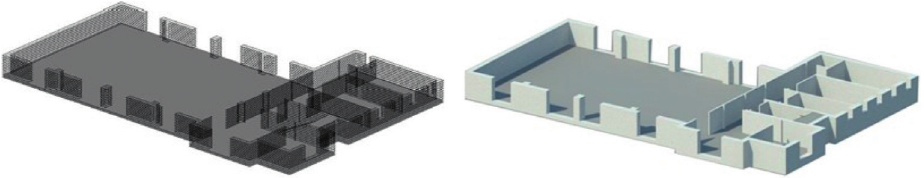
Figure 19: The printing process from STL file to the 3D printer on